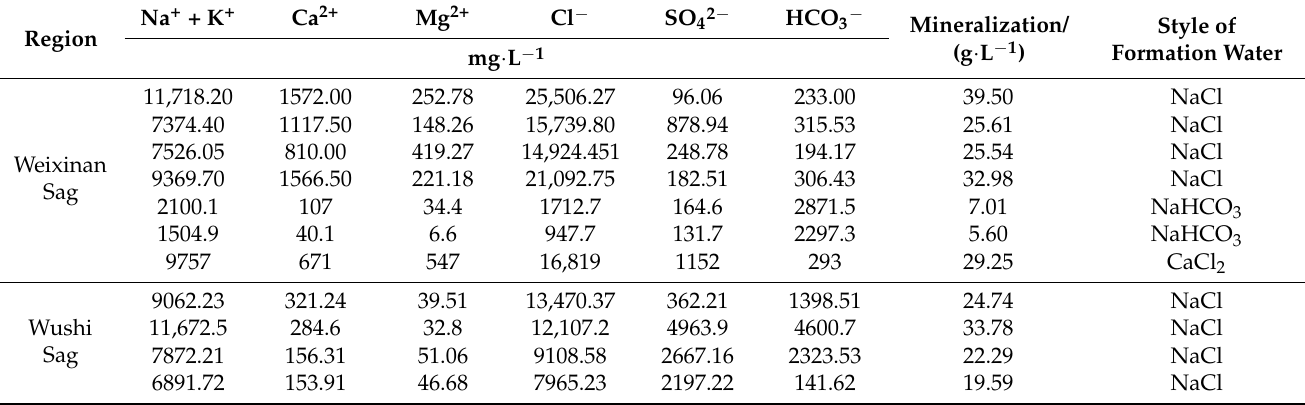
Table 1. Results of the chemical composition analysis of formation water in main target carbon reservoirs of the target in the Beibu Gulf Basin (modified after